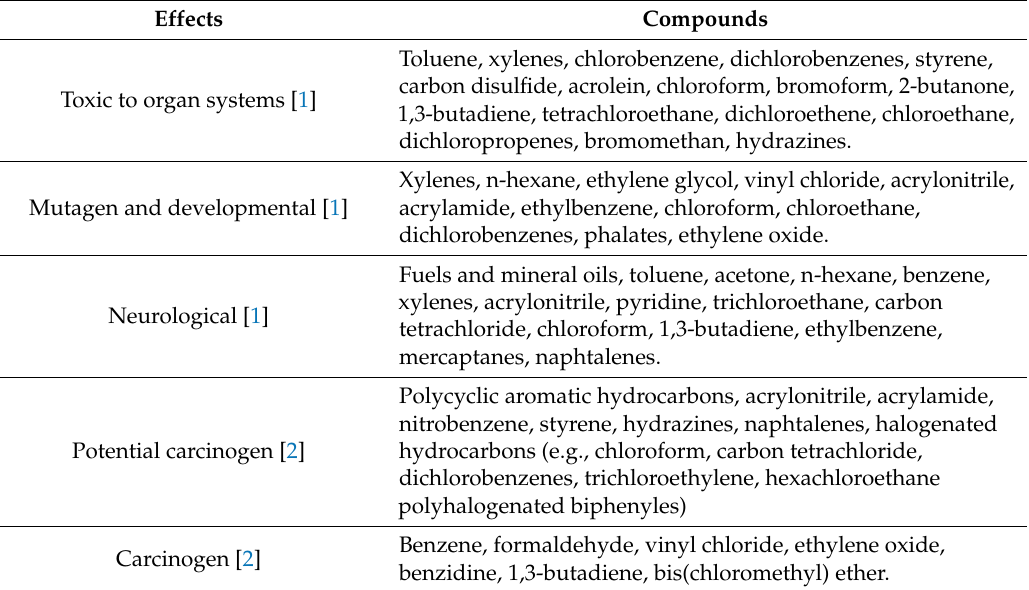
Table 1. List of common volatile organic compounds (VOCs) based on their effect on the human